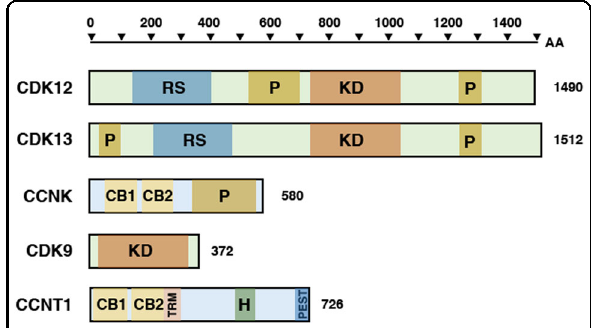
Fig. 1 Comparison of the primary structures of CDK9, CDK12, and CDK13. KD kinase domain, RS arginine/serine-rich motifs, P proline- rich motifs, CB cyclin-box, TRM TAT/TAR recognition motif, H histidine- rich segment, and PEST PEST domain. The scale indicates the length of the amino acids (AA) and